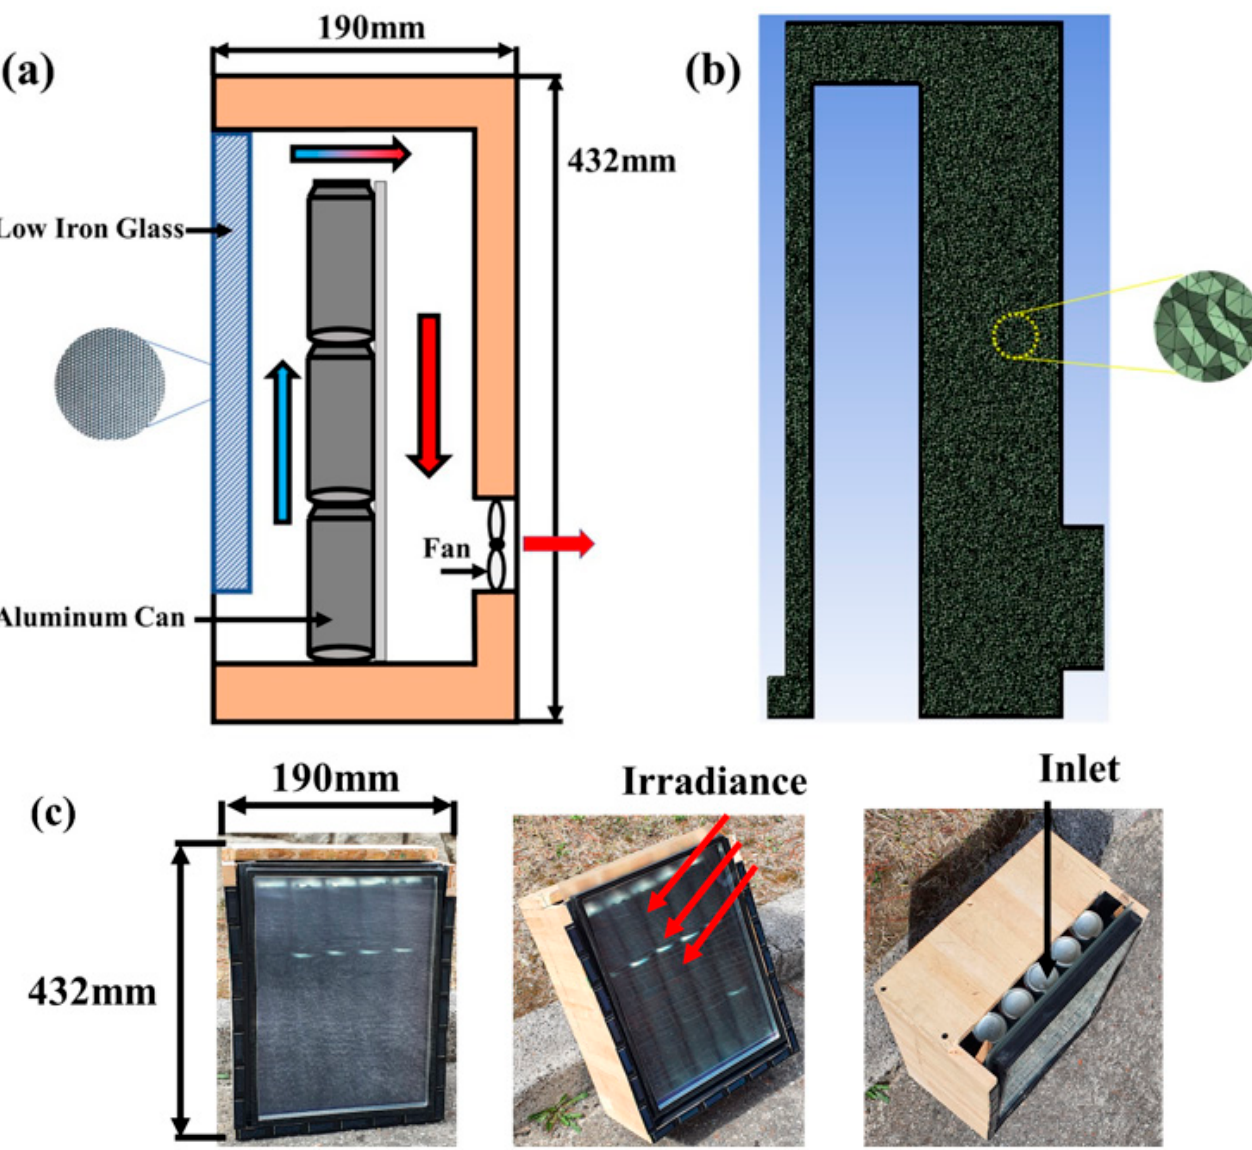
Figure 1. Solar air heater used for the experiment, ( a ) Schematic, ( b ) Tetrahedral meshes generated inside the solar heater, ( c ) Photographs of the solar air heater.